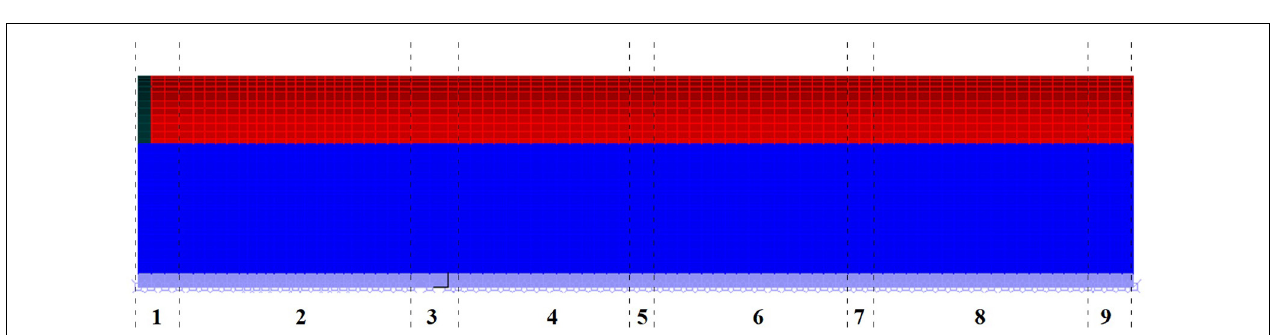
FIGURE 6 | Spatial division into nine basic structural units: 1, main gate; 2, second part; 3, inner wall+Ar1; 4, second part A; 5, Ar3; 6, second part B; 7, Ar4; 8, second part C; 9, western wall+Ar2.